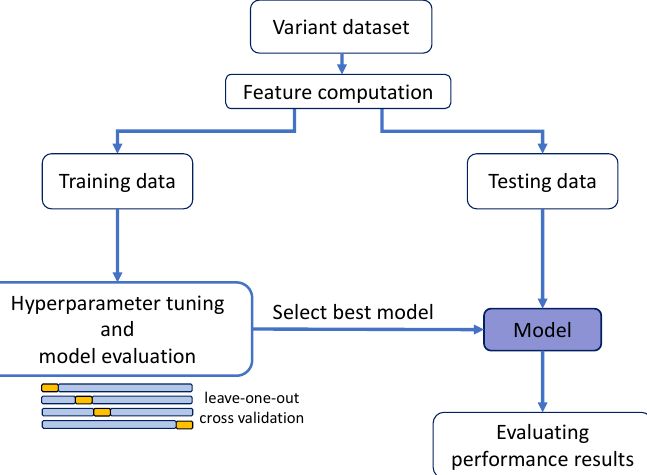
Figure 2. Scheme used to develop the regression models for obtaining the endophenotype (functional assay) estimates. The boxes represent the main steps in the process, which include the obtention of the variant dataset (a set of variants with available endophenotype values), the characterization of the variants with predictive features, etc. An important point in this scheme is the splitting of the data into two datasets, a training and a test dataset, required to avoid overfitting in the training of the regression models. When applied, the resampling step mentioned in the Discussion was executed immediately after the building of the variant dataset.